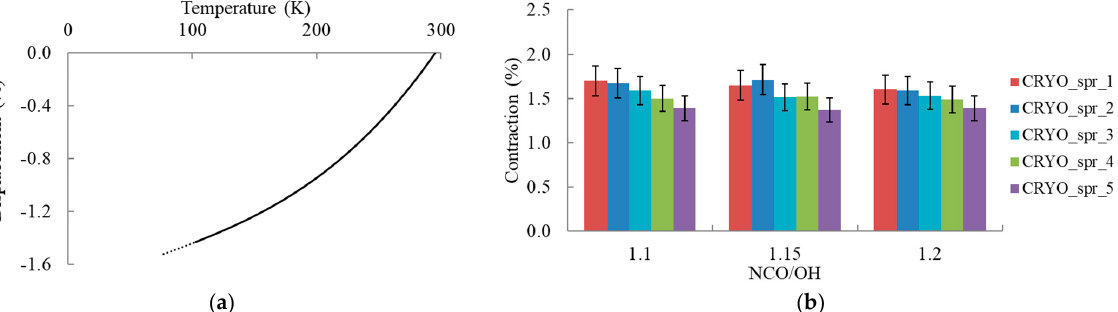
Figure 5. ( a ) Displacement curves measured by TMA test equipment with approximation; ( b ) PUR foam contraction at cooling from 275 to 77 K vs. NCO/OH ratio.